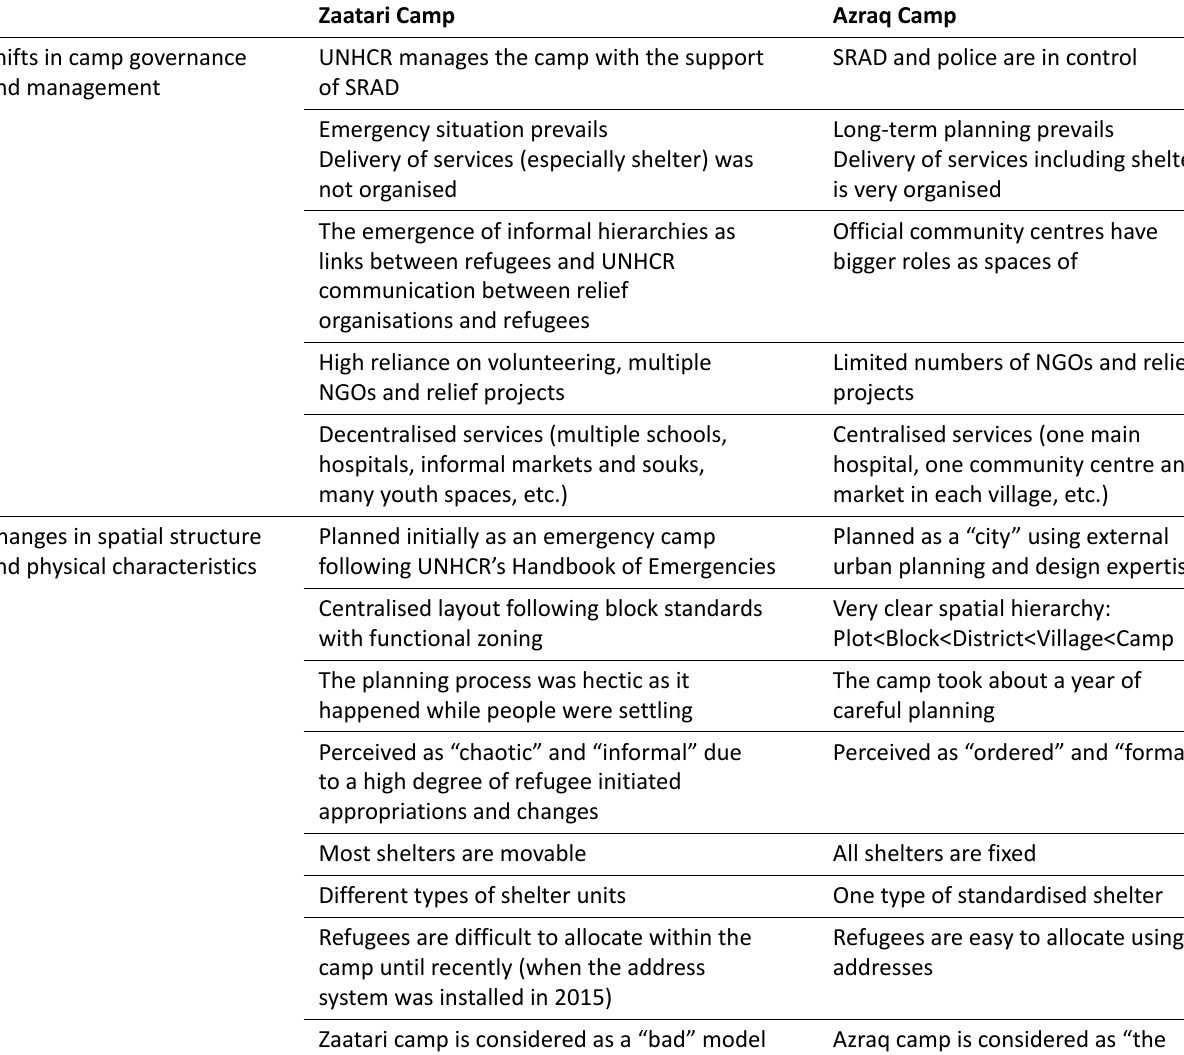
Table 1. From Zaatari to Azraq: Changes in camp governance and physical